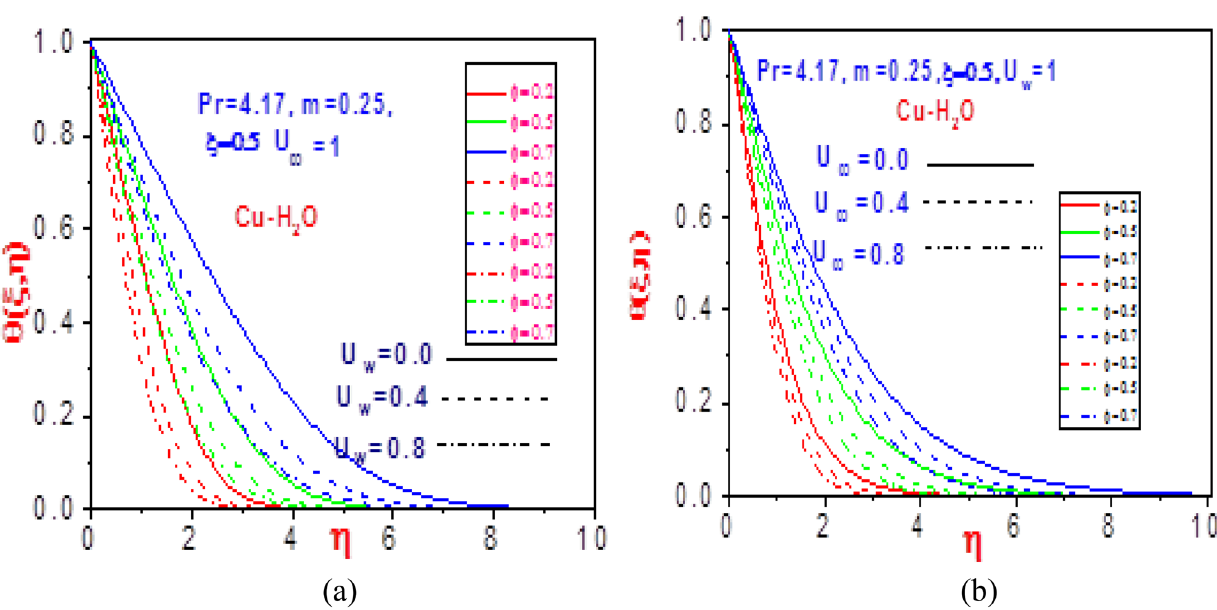
Figure 4. Profiles of temperature θ(ξ , η) for ( a ) different values of U ∞ with U w = 1 and ( b ) different values of U w with U ∞ = 1